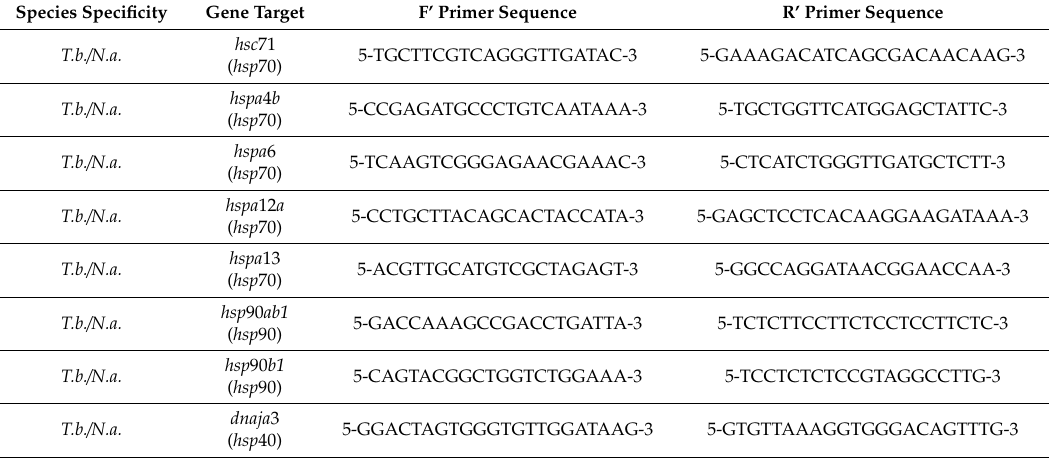
Table 1. PCR primers used for cloning. In all instances, each primer set works on both T. bernacchii ( T.b. ) and N. angustata ( N.a. ) genomic DNA.